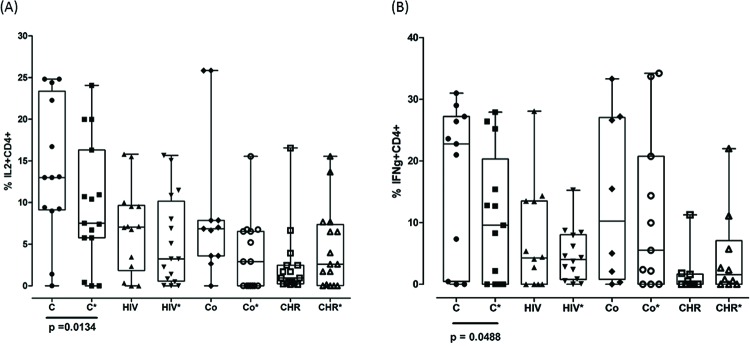
Comparison of the proportion of cytokines on T cells with and without SAg stimulus. (A). IL-2+CD4+. (B) IFN-γ+CD4+. The asterisk (*) represents the condition in which cells were stimulated with soluble T. cruzi antigen. The difference between non-stimulated and stimulated* cells was significant for IL-2+CD4+ (Wilcoxon test, p=0.0093) and IFN-γ+CD4+ T cells (Wilcoxon test, p=0.048). No statistically significant differences were observed in relation to the other phenotypes.